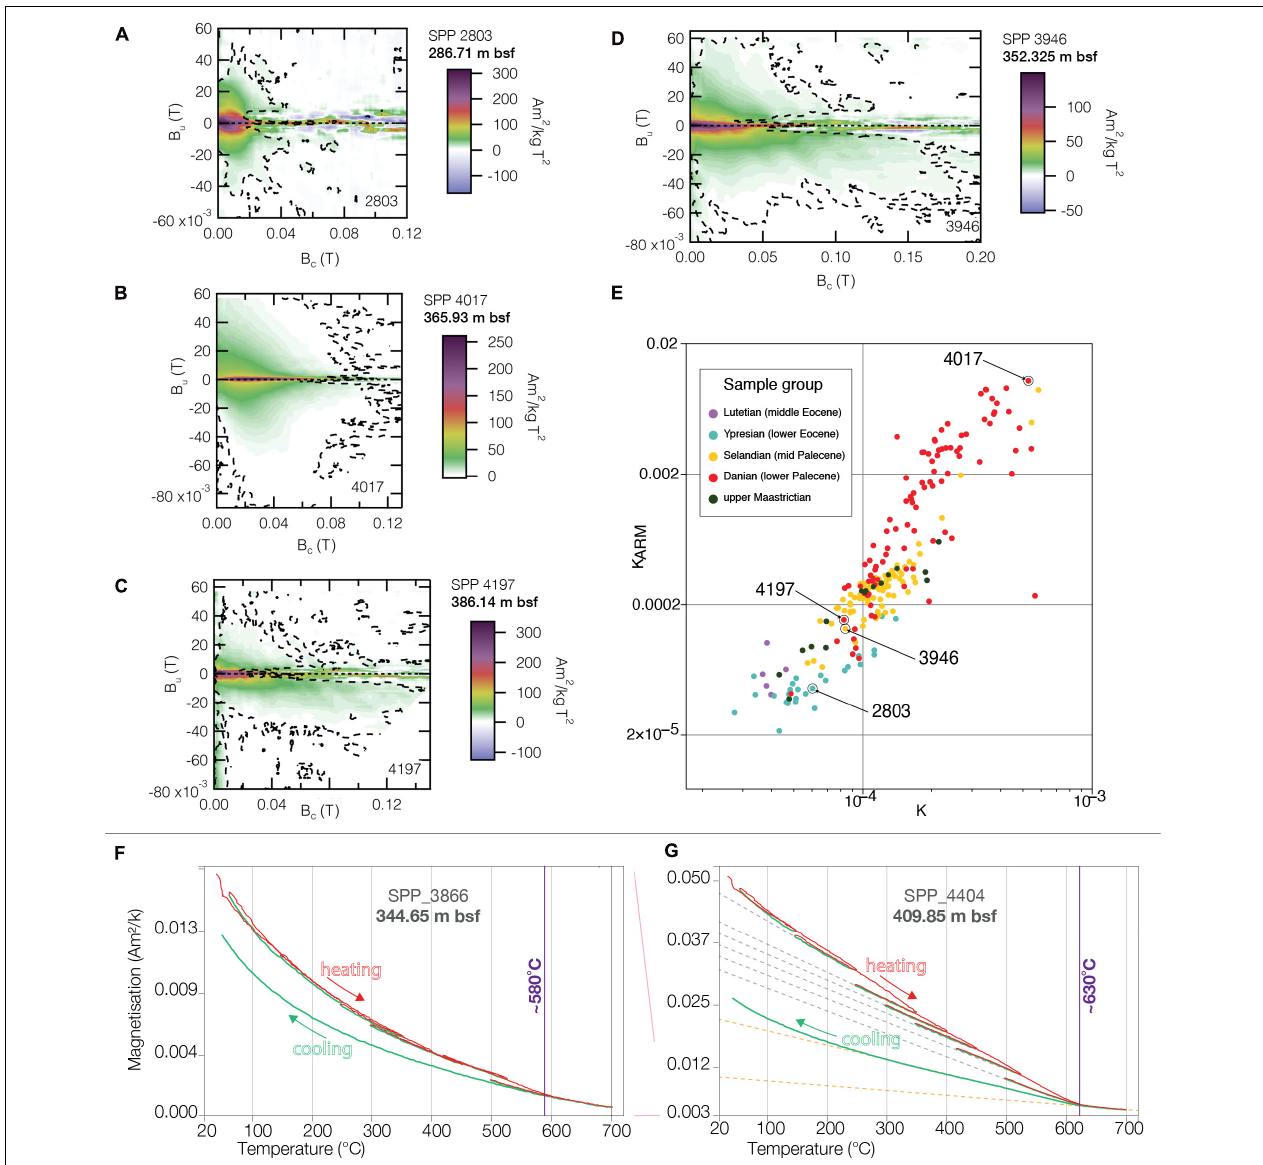
FIGURE 5 | Rock magnetic characterization of Site 356. (A–D) Selected First order reversal curve (FORC) diagrams from different stages: (A) Ypresian (2803), (B,C) Danian (4017, 4197) (D) Selandian (3946); (E) KARM/K plot (Banerjee et al., 1981; King et al., 1982) with marked locations of FORC diagrams; (F–G) Results of thermal experiments using a Curie Balance, for samples 3866 (Selandian) and 4404 (Danian). Purple lines indicate unblocking temperatures. Gray dotted lines represent the projected cooling curves at a given step. See text for